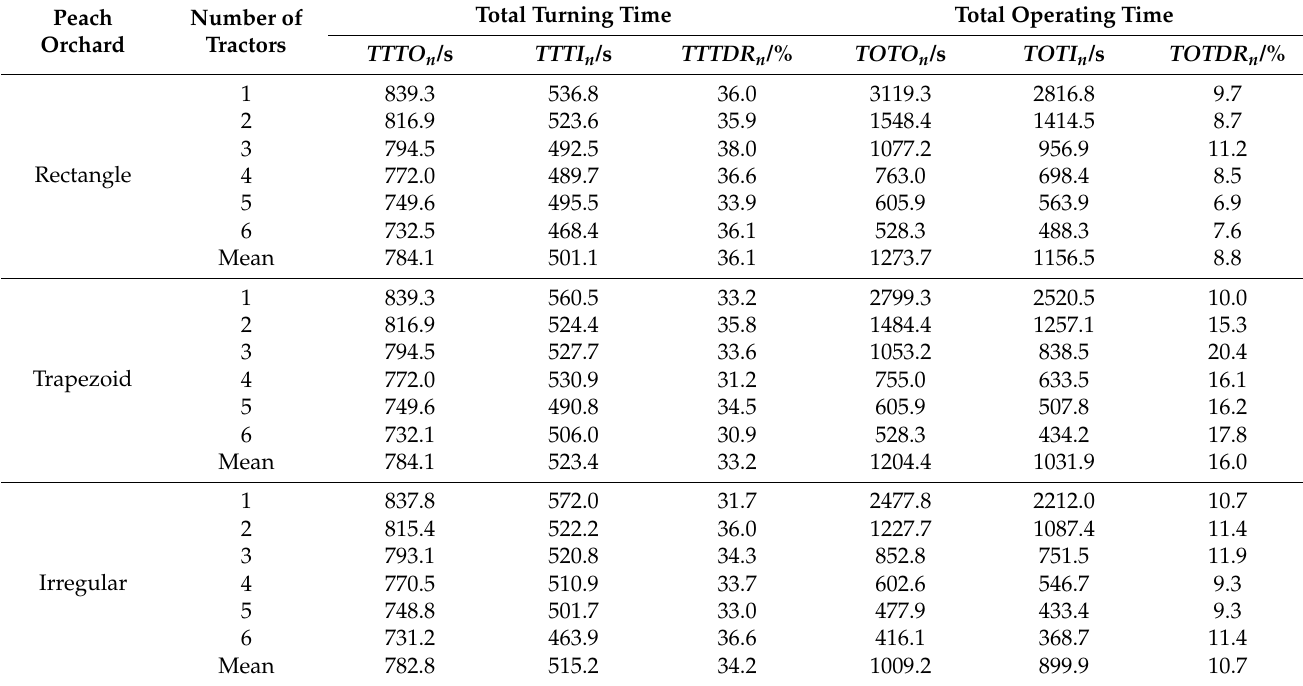
Table 2. Comparison of total turning time and total operating